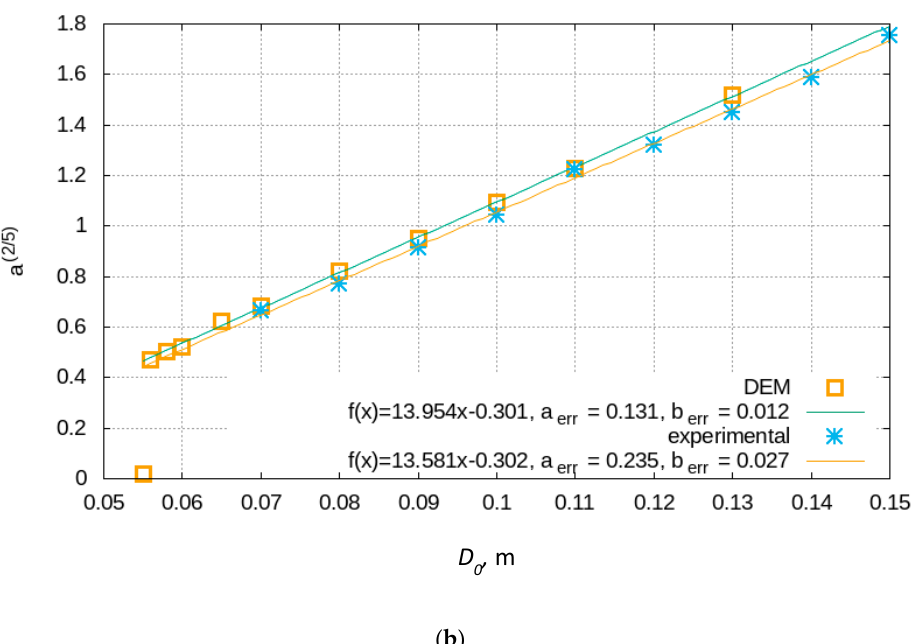
Figure 3. Relationships between the diameter of the discharge orifice D 0 and the outflow rate a ( a ), and at power 2/5: experimental data, numerical results, and Beverloo law fitting ( b ).